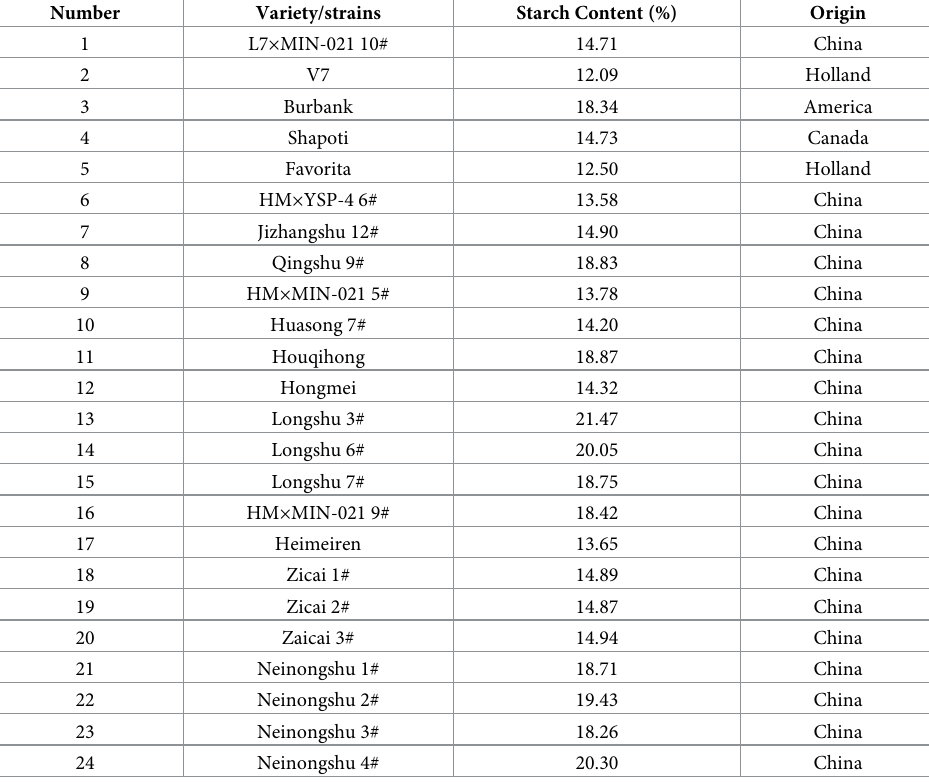
Table 5. Potato varieties and strains information.